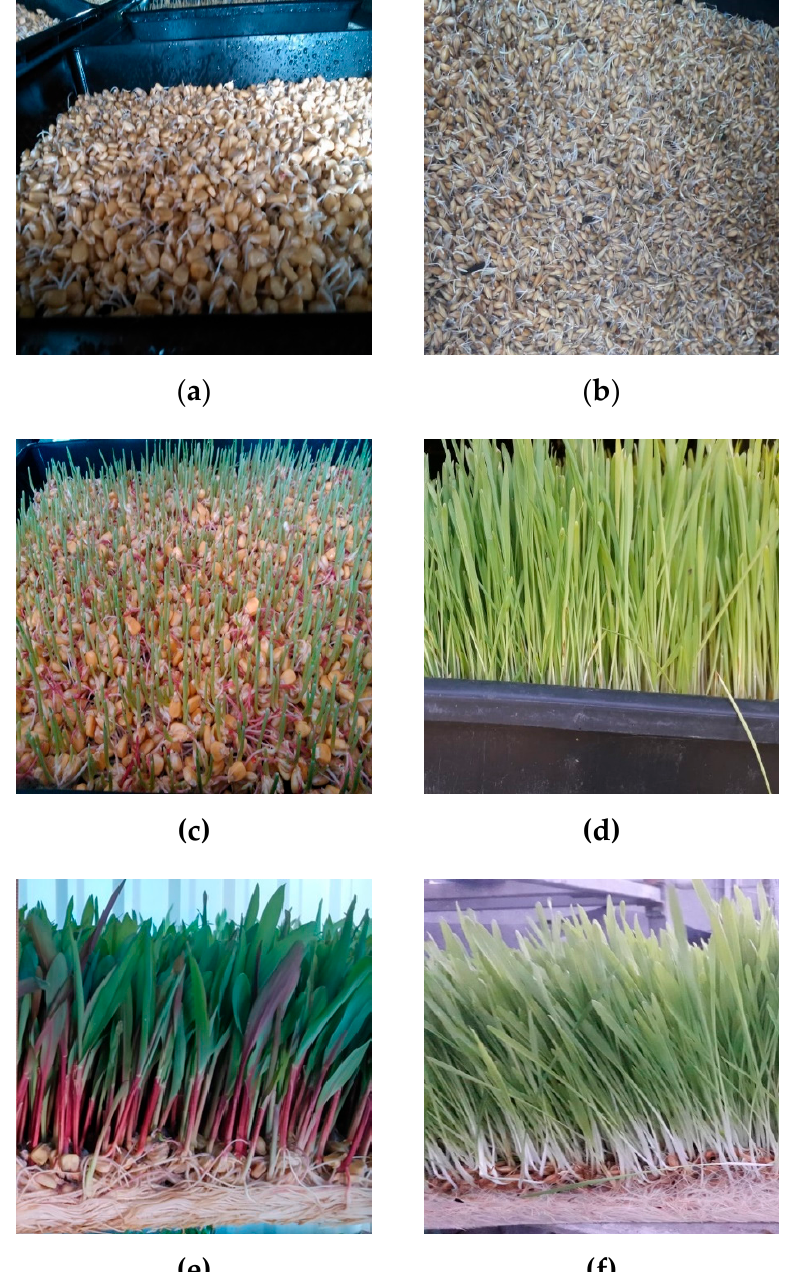
Figure 5. Comparative temporary crops of hydroponic green forage using Zea mays and Hordeum vulgare in the GCH. ( a ) The third day of corn. ( b ) The third day of barley. ( c ) The tenth day of corn. ( d ) The tenth day of barley. ( e ) The fifteenth day of corn. ( f ) The twelfth day of barley. Table 4 provides information about the kilograms of wet forage obtained for a TC of corn in a Table 4. Results of the hydroponic green forage of Zea mays for a production cycle of 15 days. Equally, in Table 5, the results for a TC of barley in a cycle of 12 days are presented. Sowing The conversion factor relates dry seed to fresh forage of the same sample produced in the GCH, and di ff ers from the conversion ratio (CR), which considers the concentration of dry